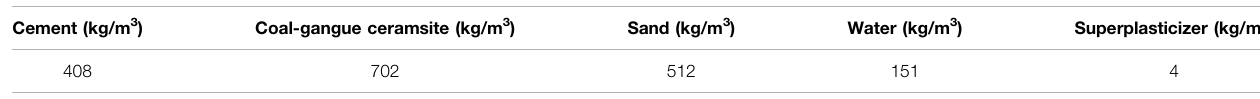
TABLE 1 | Mix ratio of coal-gangue ceramsite lightweight aggregate concrete.